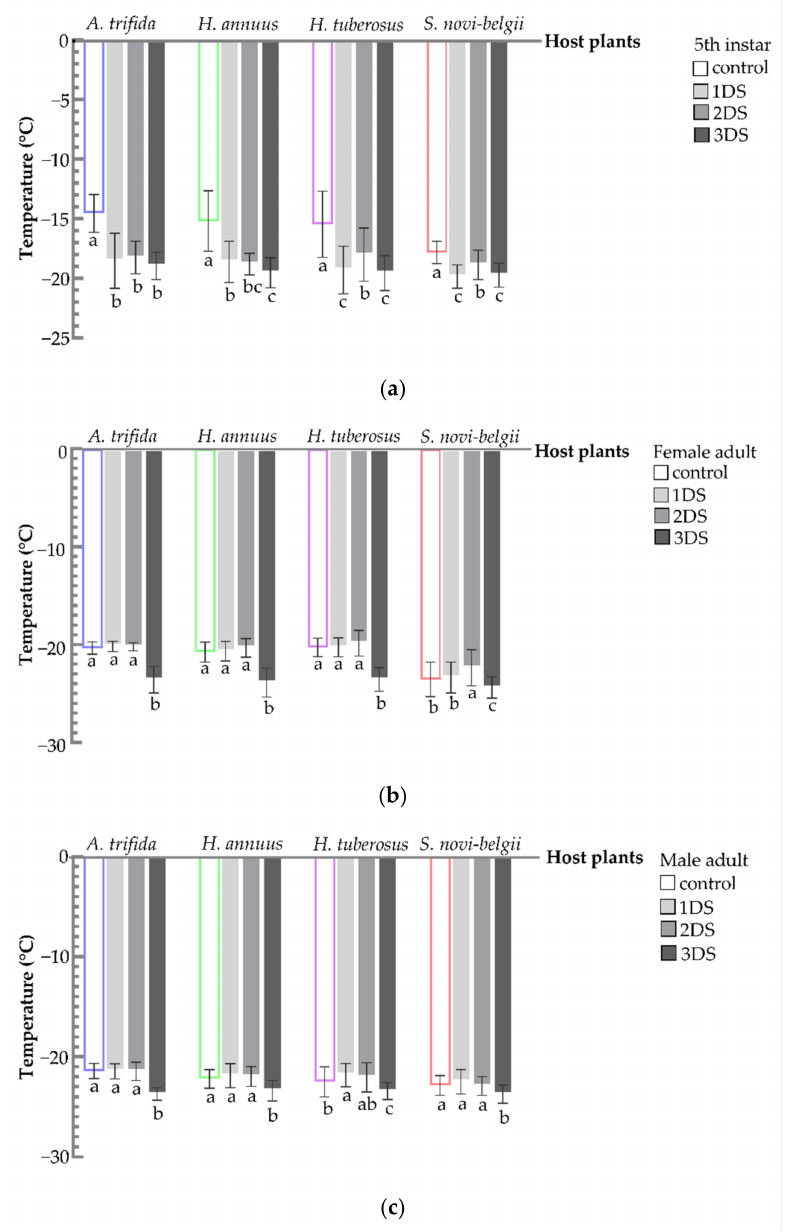
Figure 7. Freezing point of C. marmorata suffering from food deprivation on four host plants. ( a ) FP of 5th instar nymph; ( b ) FP of female adult; and ( c ) FP of male adult. Control: the group offered host leaflets continuously without food deprivation; 1DS: the group subjected to 1 day’s starvation; 2DS: the group subjected to 2 days’ starvation; and 3DS: the group subjected to 3 days’ starvation. Values are the mean ± SD. Different lowercase letters “a, ab, b, bc, c” in one species of host plants indicate significant differences (one-way analysis of variance followed by Duncan’s test, p <